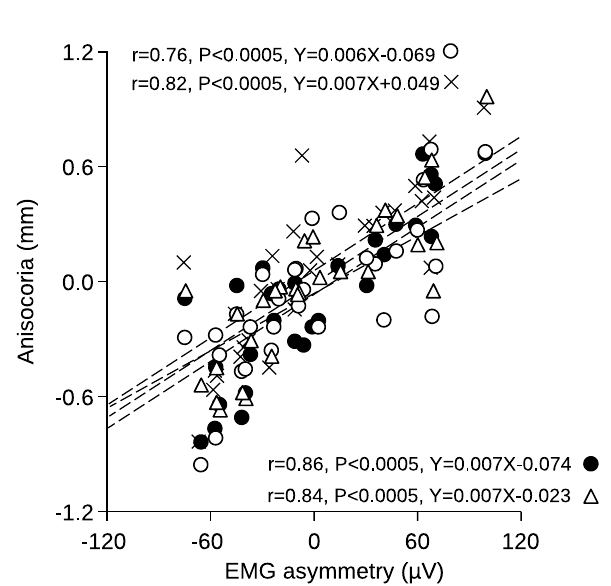
Figure 2. Stability of performance in different experimental sessions. The Performance Index (a) and the Scanning Rate (b) have been recorded in four different experimental sessions (trials). Values relative to the second, third and fourth trial have been plotted as a function of the initial value. The corresponding coefficients of correlation and regression lines equations have been reported in both A and B. Dotted lines represent equal values on X and Y axes.